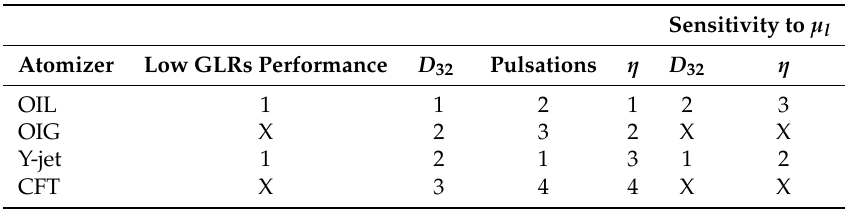
Table 9. Overall rating of our atomizers for spraying at low